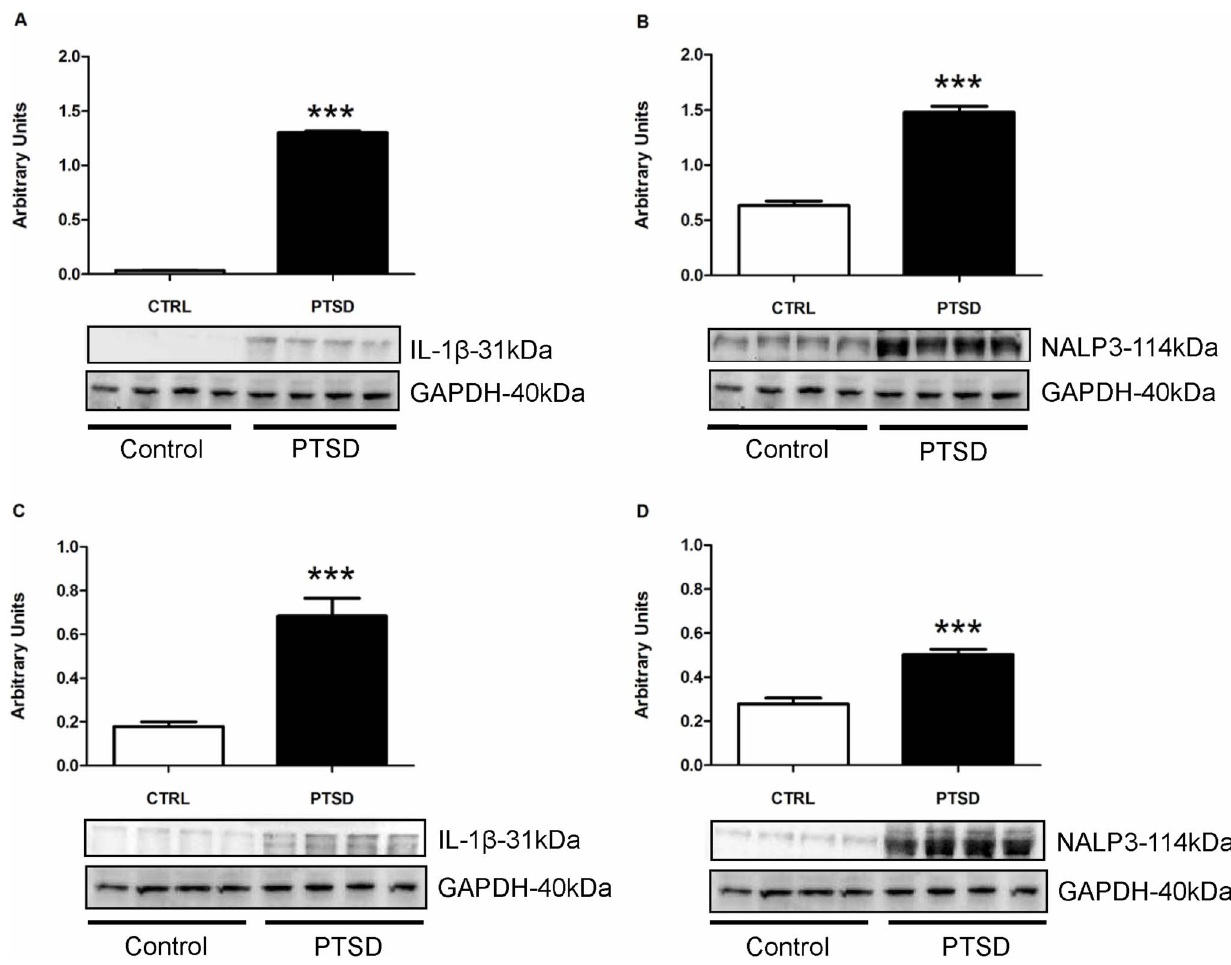
Figure 7. Western blot on the hippocampus (A &B) and PFC (C & D) tissue. Western Blot showed IL-1 b and NALP3 protein in the hippocampus (A & B respectively) and PFC (C & D respectively) were significantly elevated in the PTSD group. All data presented as mean 6 SEM. *p , 0.05 relative to the control group.